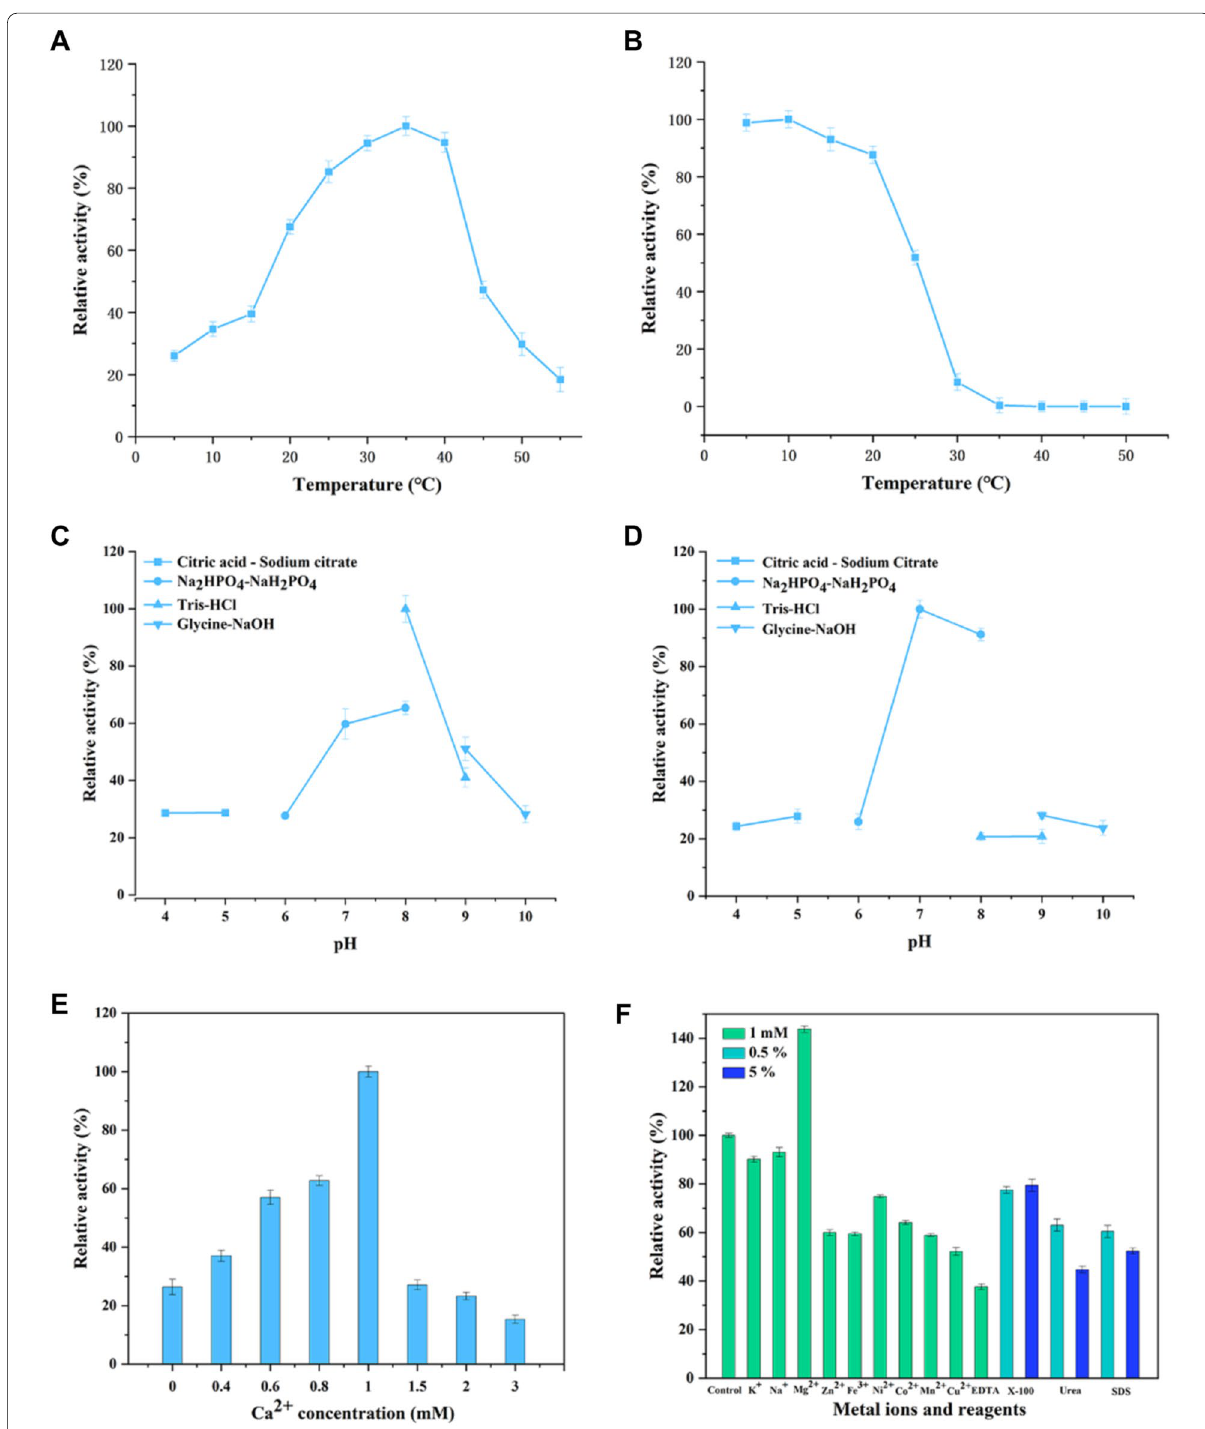
Fig. 5 Biochemical characterization of ErPelPL1. A The optimal temperature of ErPelPL1. B The thermal stability of ErPelPL1. C The optimal pH of ErPelPL1. D The pH stability of ErPelPL1. E The optimal Ca 2 + concentration of ErPelPL1. F The effects of various metal ions and reagents on ErPelPL1. Each value represents the mean of three replicates standard deviation. The enzymatic activity without adding metal ions or reagents was ± designated as 100% served as the